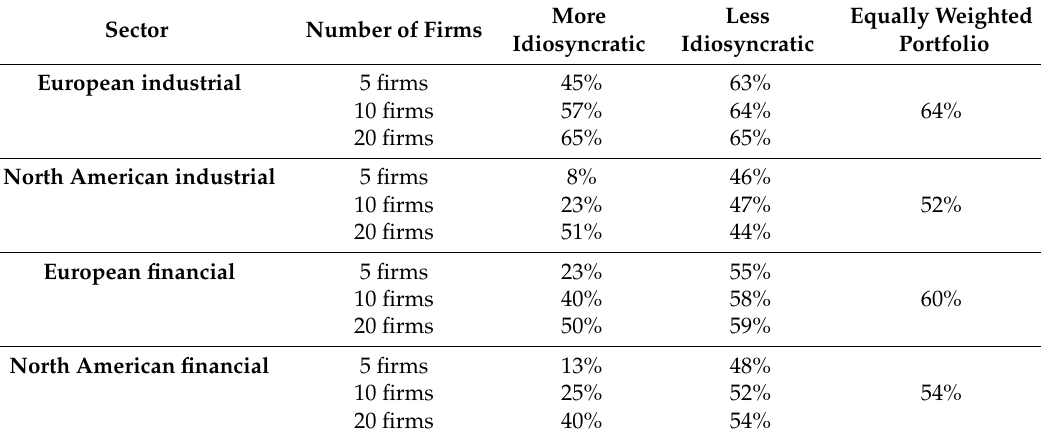
Table 14. Variance reduction for sectorial